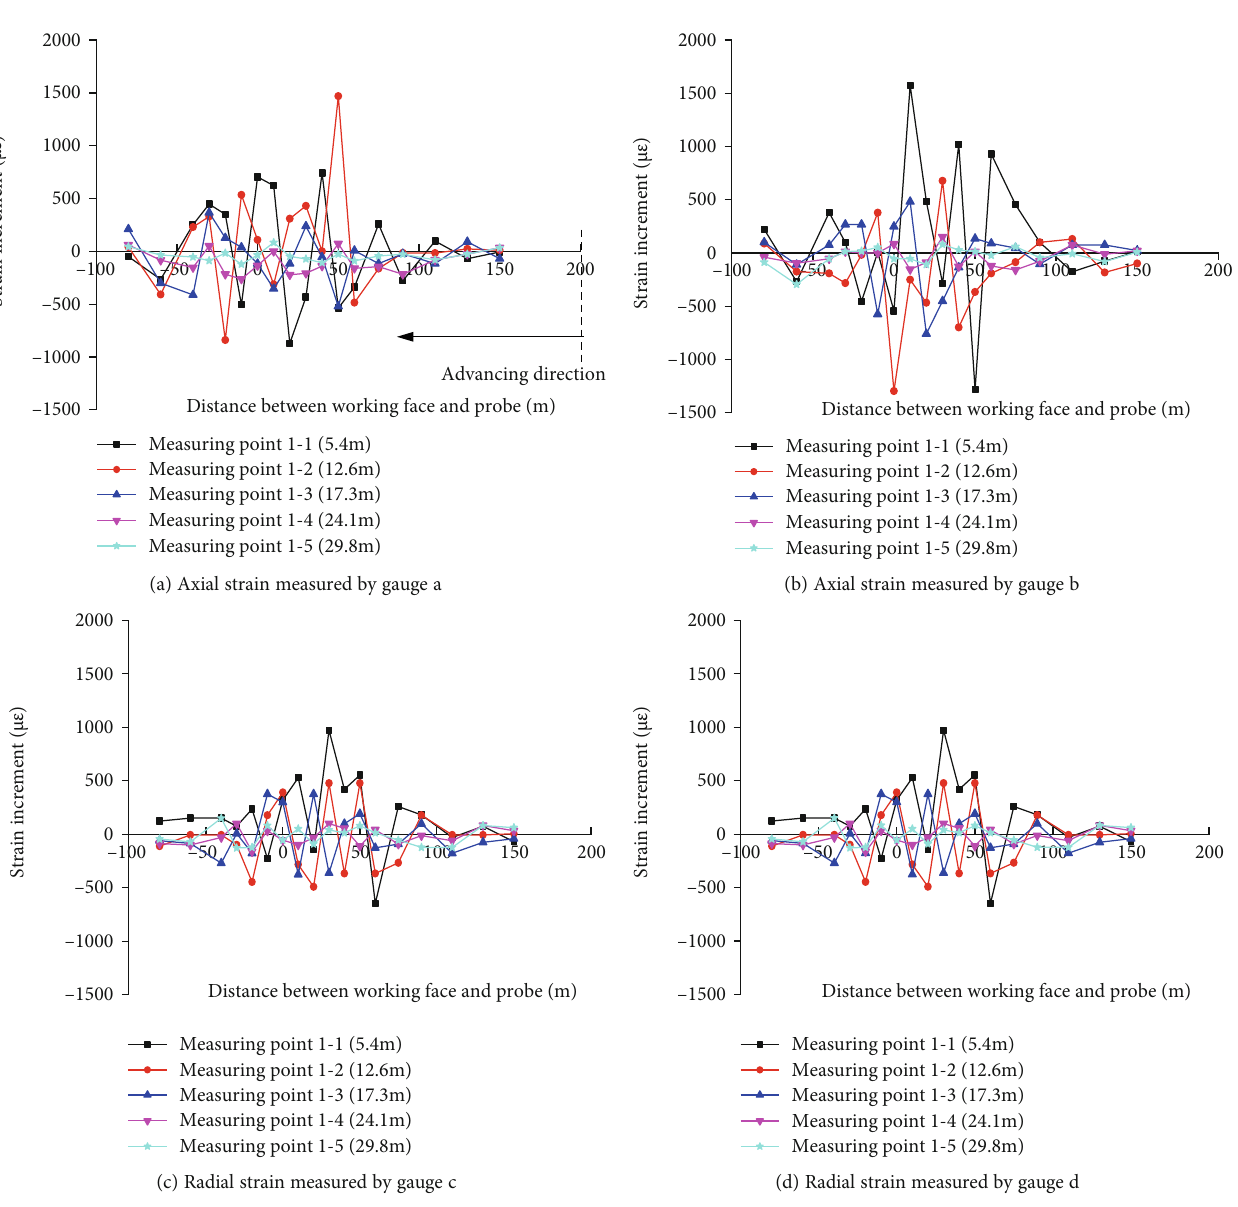
Figure 6: The increment of axial strain and radial strain of the No. 2